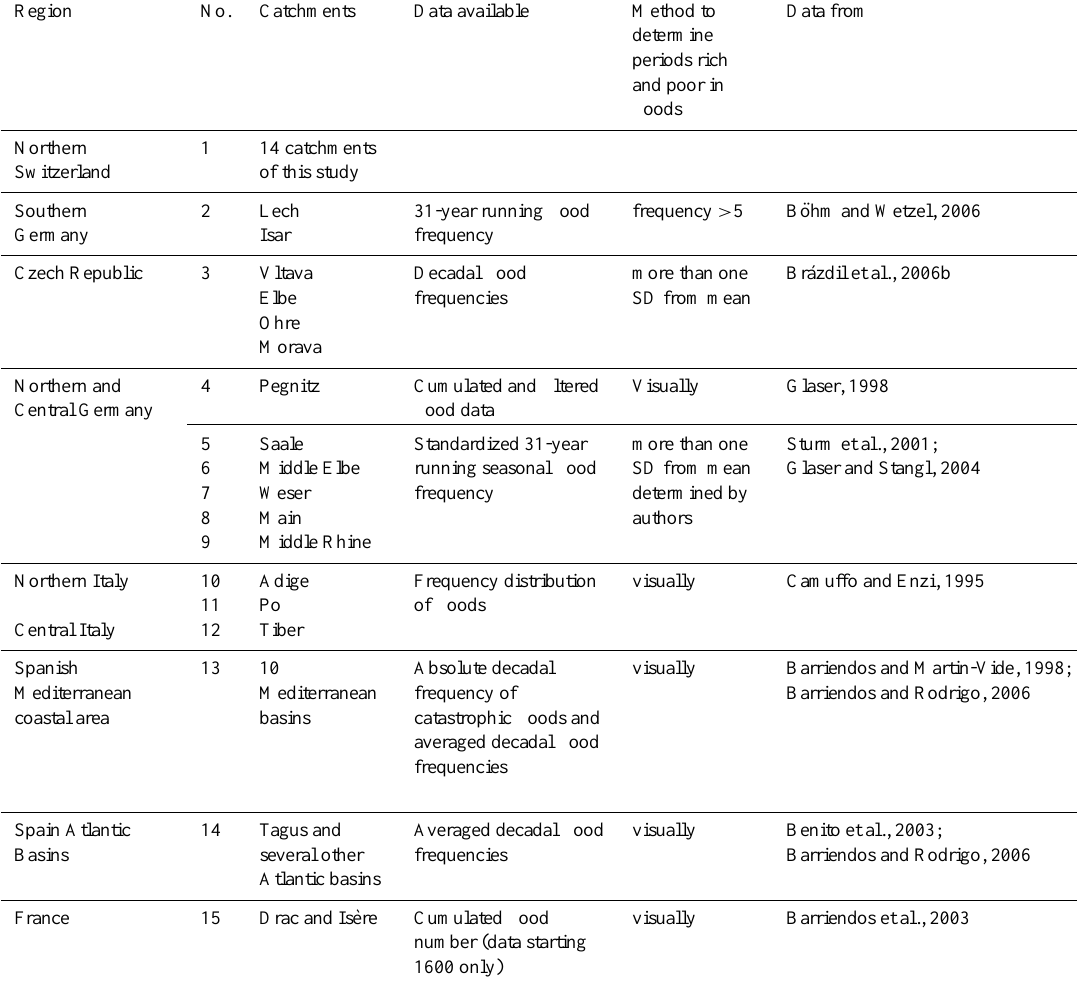
Table 2. The catchments, data and methods used for a comparison of flood frequency on a European scale for the period 1560–1810. In all cases unless otherwise mentioned, we determined the periods rich and poor in